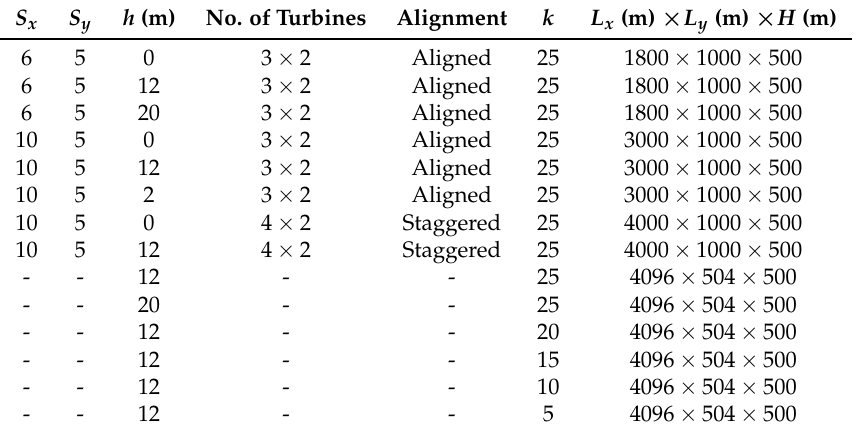
Table 1. Windbreak and wind farm cases inspected with large-eddy